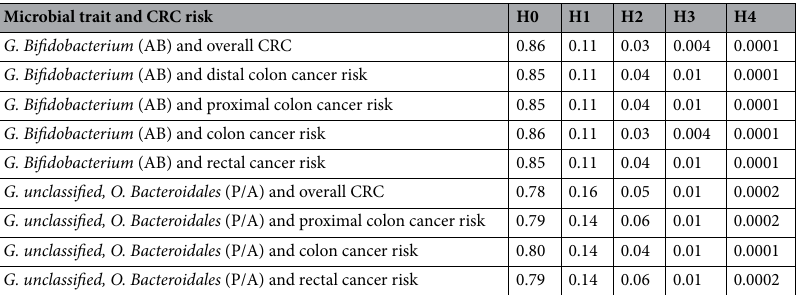
Table 2. Posterior probabilities relating to associations between microbial traits and both overall and site- specific colorectal cancer. AB = abundance; CRC = colorectal cancer; P/A = presence versus absence. Letters in the microbial trait name represent the taxon classification level from which that microbial trait was observed, with “ G ” and “ O ” representing “genus” and “order”, respectively. All microbial traits that were not confidently classified at the genus level were organised into unclassified groups within higher classification levels (represented by “unclassified”). H0: Neither trait has a genetic association in the region, H1: Only the first trait (i.e., the microbial trait) has a genetic association in the region, H2; Only the second trait (i.e., CRC risk) has a genetic association in the region, H3: Both traits are associated but have different causal variants and H4: Both traits are associated and have the same causal